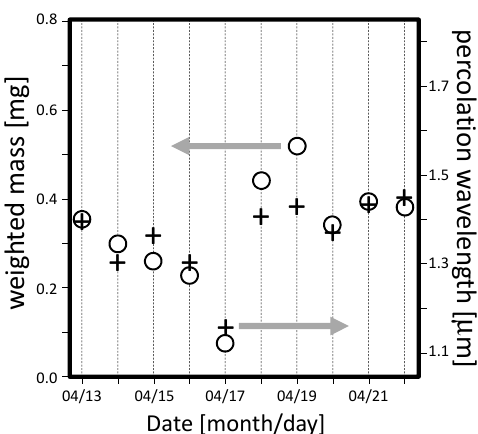
Figure 7. Daily PM10 concentration obtained using the optical (crosses) and the gravimetric (circles) techniques, for the campaign 13–22 April 2016. The two point sets almost overlap everywhere but on 18–19 April. From the environmental monitoring, it was pointed out that such two days had an anomalous amount of humidity that we believe affected the gravimetric measurements but not the optical ones.